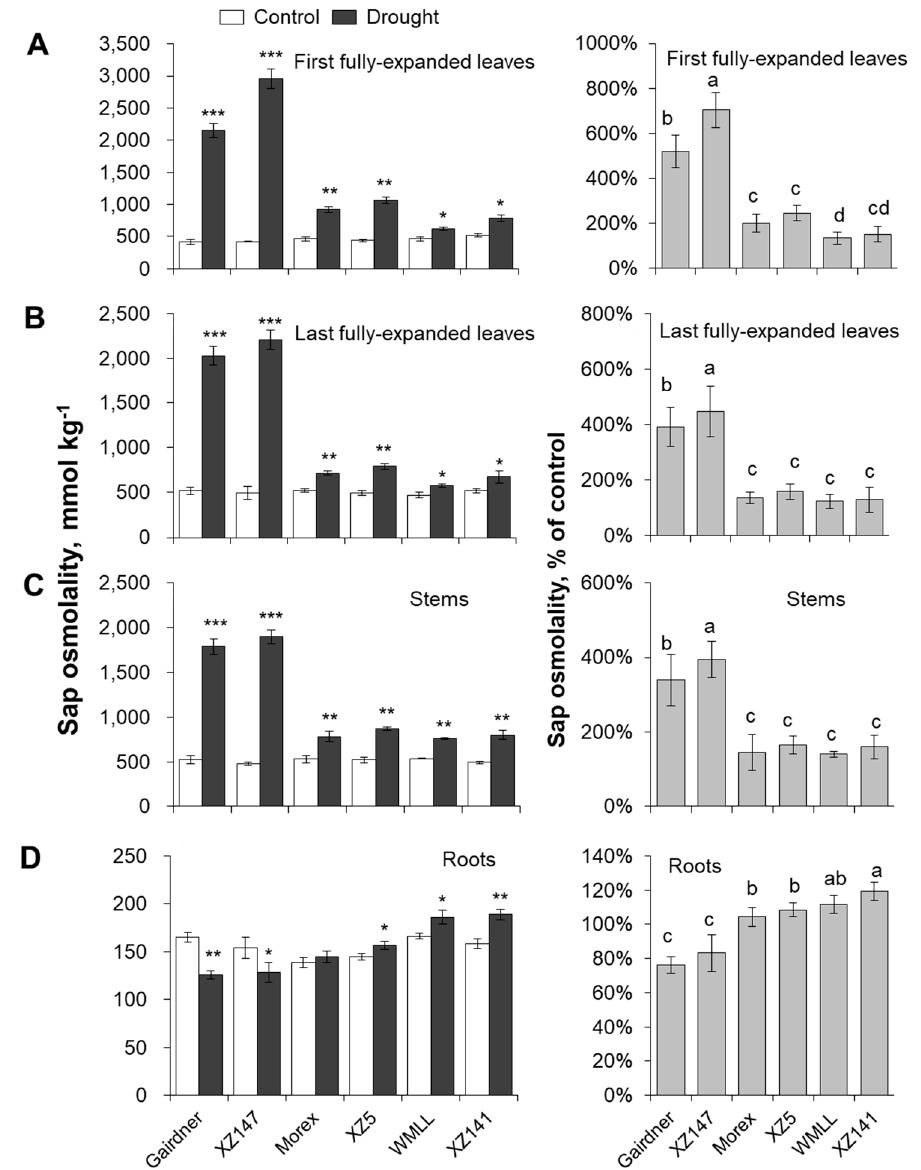
E ff ect of water-limited drought stress on osmotic adjustment of barley seedlings. Twelve-day-old barley seedlings were subjected to drought stress. Plants were harvested for osmolality analysis in first ( A ) and last ( B ) fully-expanded leaves, stem ( C ) and root ( D ) at 10 d after onset of treatments. Vertical bars represent means ± SE of five replicates. Asterisks indicate the significant di ff erence between treatments at * p < 0.05, ** p < 0.01 and *** p < 0.001. Di ff erent lowercase letters indicate the significant di ff erence between genotypes at p < 0.01.